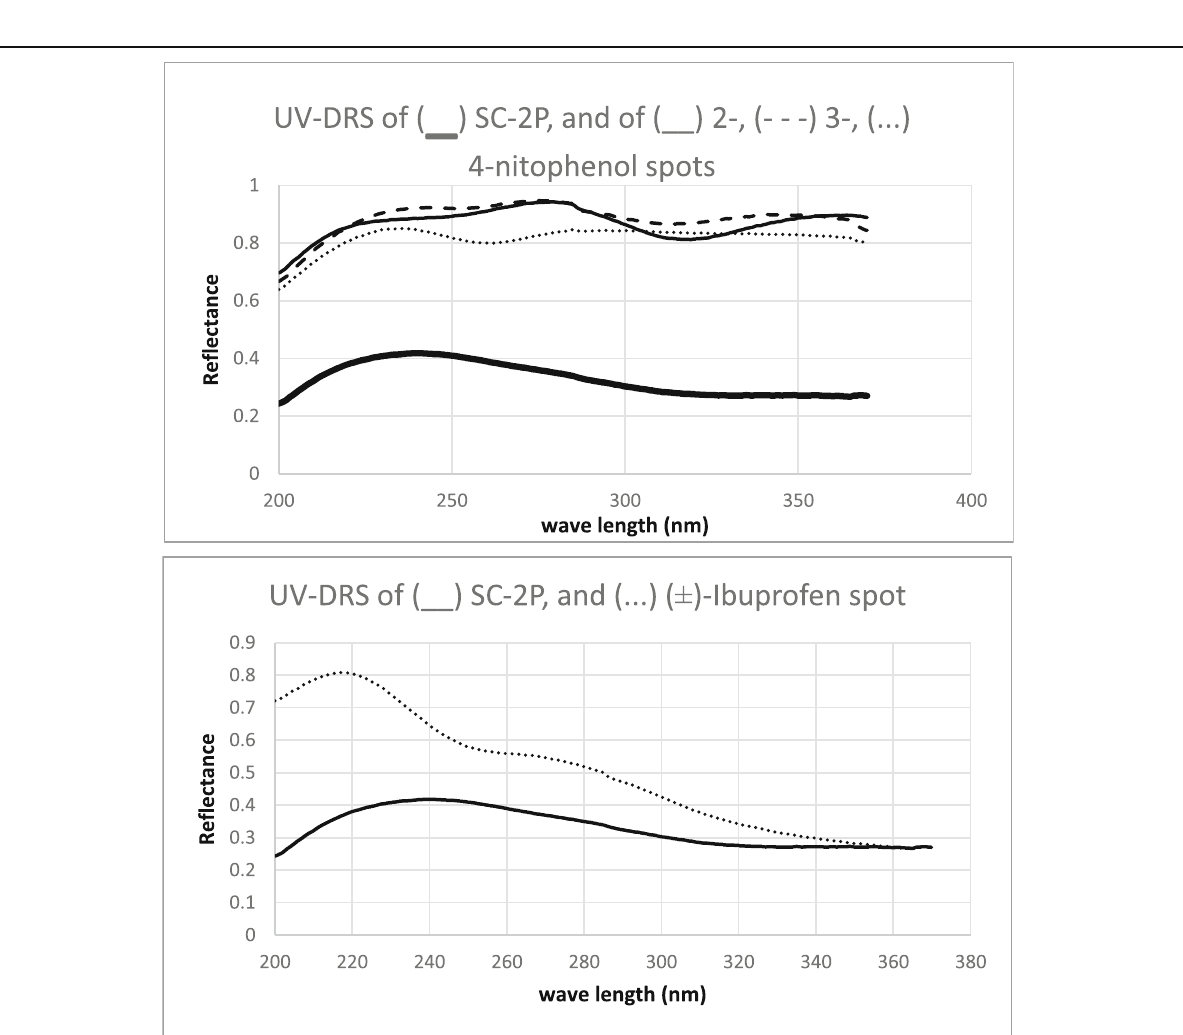
Fig. 3 UV-DRS spectra of the prepared TLC plates and for the